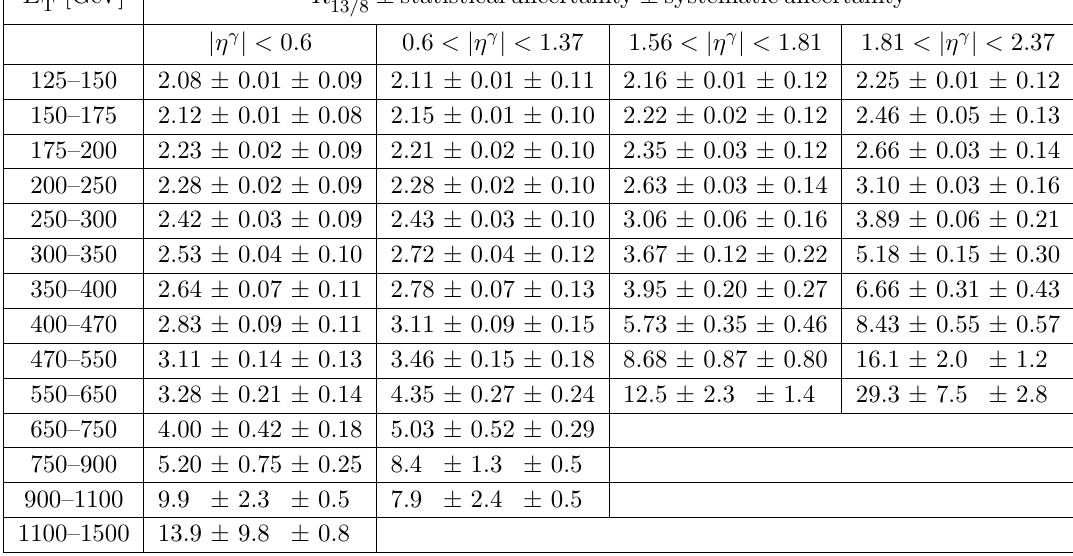
Table 1 . The measured R (cid:13) total systematic uncertainty in di(cid:11)erent regions of j (cid:17) (cid:13) j